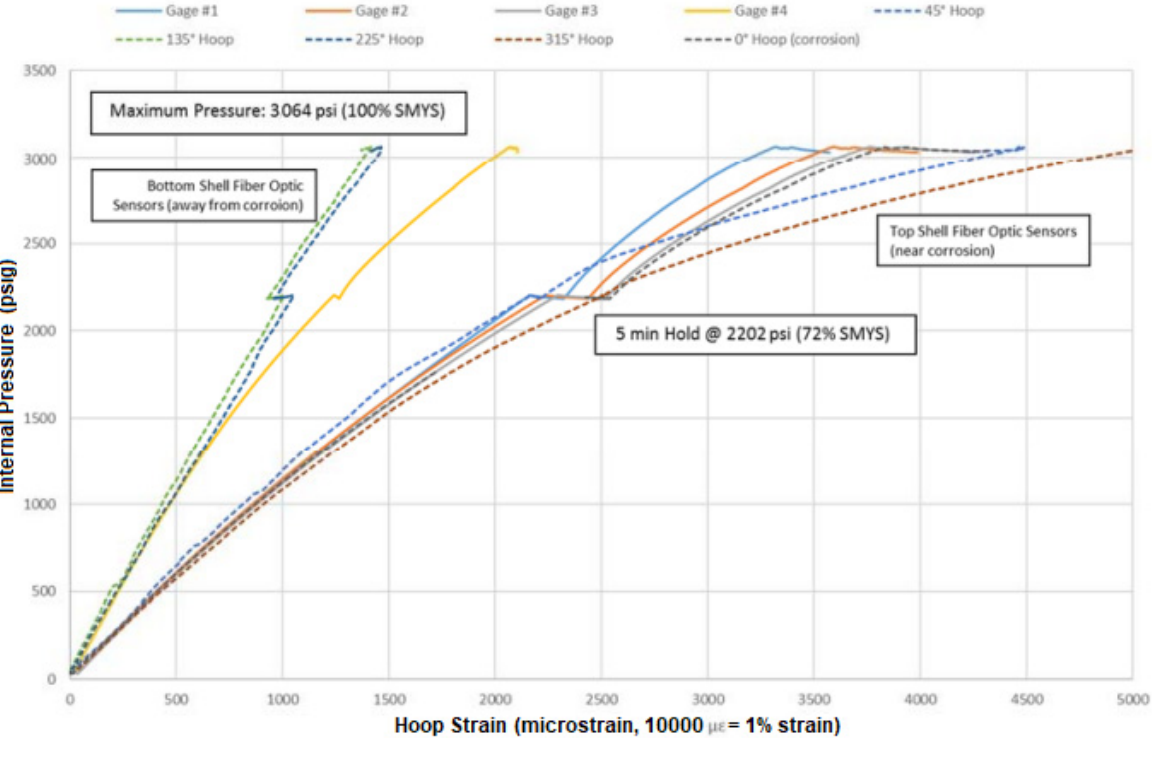
Figure 17 . Result of Hoop strain against internal pressure using the ComposiSleeveTM sample (Reprinted/adapted with permission from Dr. Chris Alexander; Source: Ref. [63]. Copyright year: 2018, copyright owner’s name: ASME & Dr. Chris Alexander) .